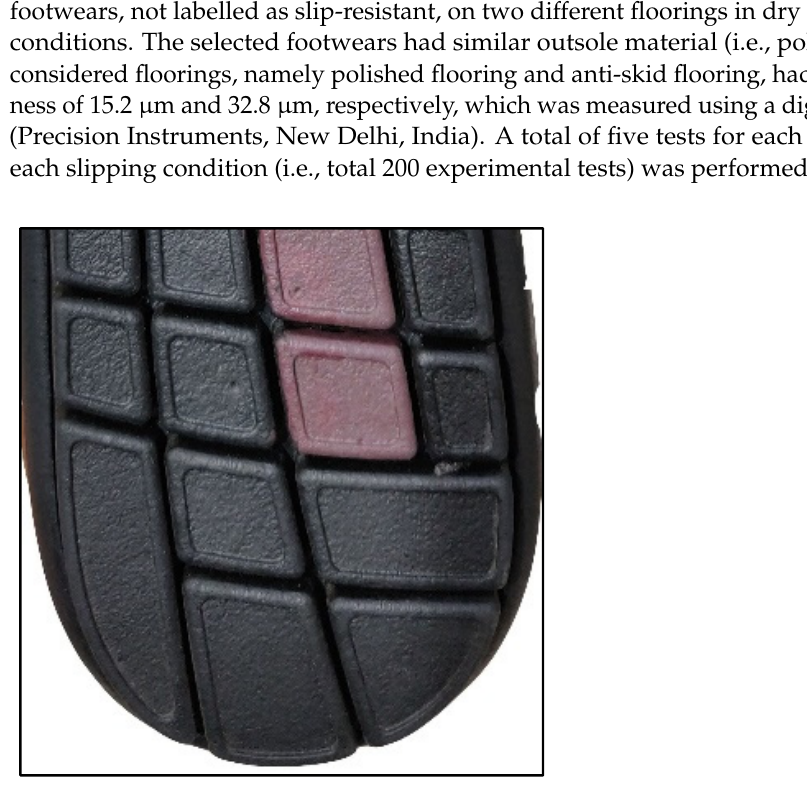
Figure 4. Shoe test sample used for the validation of normal load and IMU.